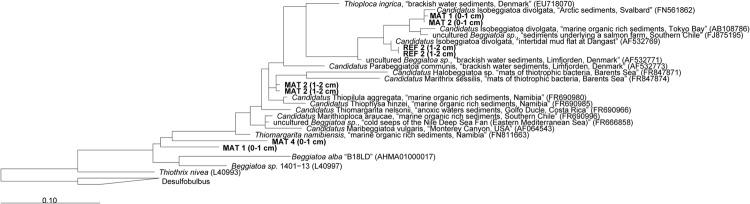
Phylogenetic 16S rRNA gene based tree showing the affiliation of sequences extracted from mat-covered and reference sediments of the Crimea margin with other filamentous sulfur-oxidizing bacteria. Mats and references sequences were screened for relatives of large sulfur oxidizing bacteria and extracted from the data set using the “grep” function in R. Initial tree reconstruction was conducted with nearly full-length sequences (1200–1400 bp). Partial sequences were subsequently inserted into the reconstructed consensus tree by applying the parsimony criteria. The scale bar corresponds to 10% estimated sequence divergence. Phylogenetic classification was carried out with the software package ARB (Ludwig et al., 2004) based on the SILVA database (SSURef v119, release date: 24 July 2014). The phylogenetic tree was calculated with the maximum likelihood algorithm PHYML (100 bootstraps) as implemented in ARB using a positional variability filter.